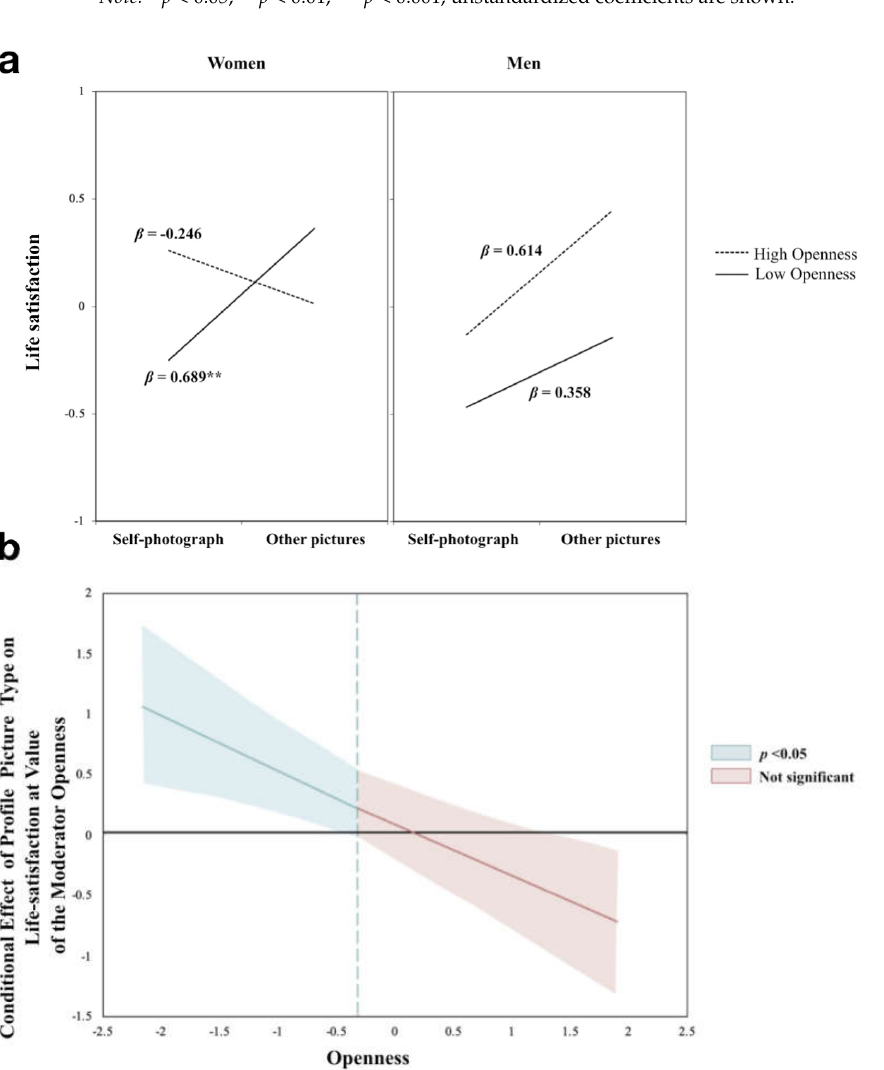
Figure 1. ( a ) Interaction of openness and profile type on life satisfaction. ( b ) Region of significance (95% confidence interval) for the conditional relation between openness and profile type on life satisfaction. Note. The dashed vertical line denotes the turning point from non-significance to significance of the effect of openness.